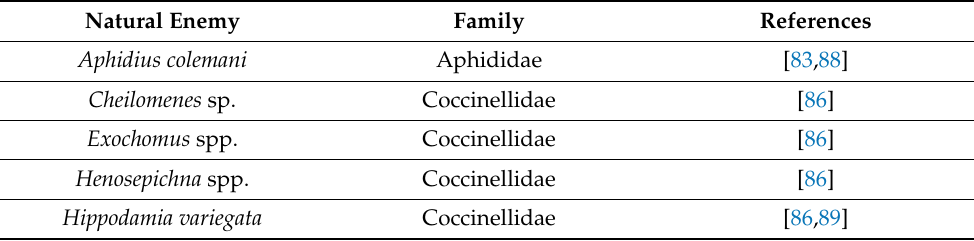
Table 4. Natural enemies for black bean aphids ( Aphis fabae ), also recorded in SSA. Natural Enemy